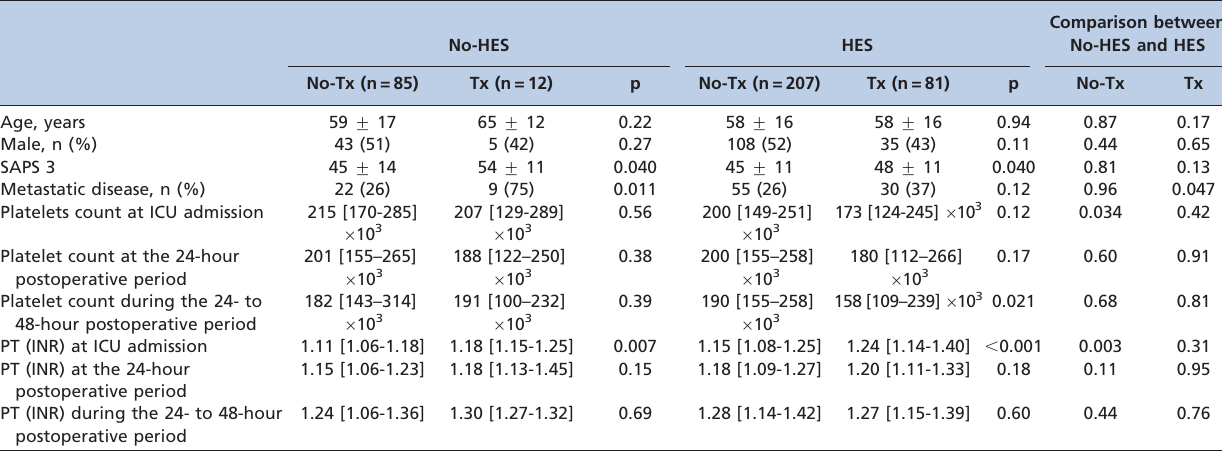
Table 4 - Characteristics of the transfused and non-transfused patients in the HES and No-HES groups.